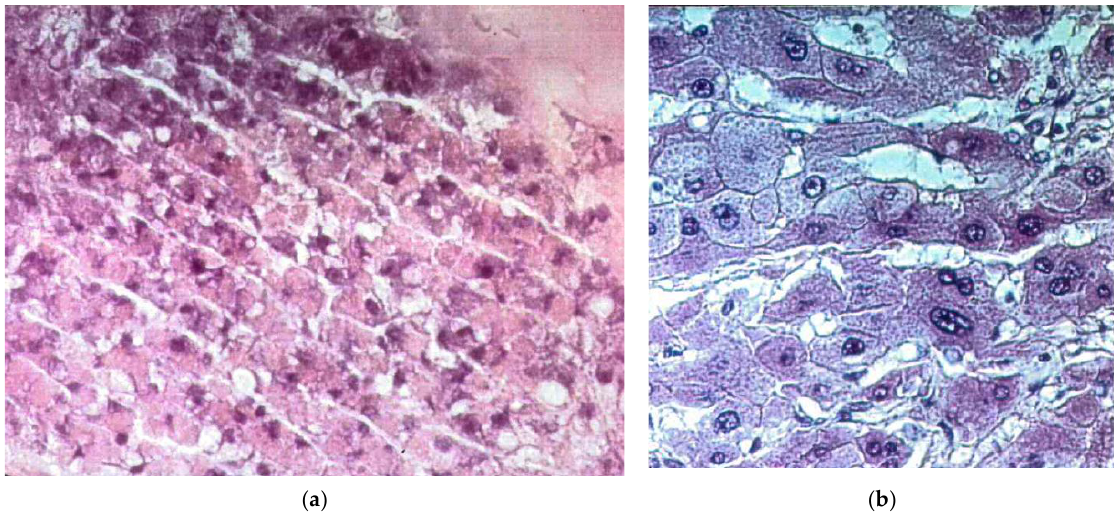
Figure 6. MEGX concentration profile in time during the kinetic tests ( n = 3) with adherent cells at various days of culture: ( a ) — ( ◆ ) day 2; ( ▲ ) day 3; ( b ) — (  ) day 4; ( ⚫ ) day 5. Lines are model predictions.